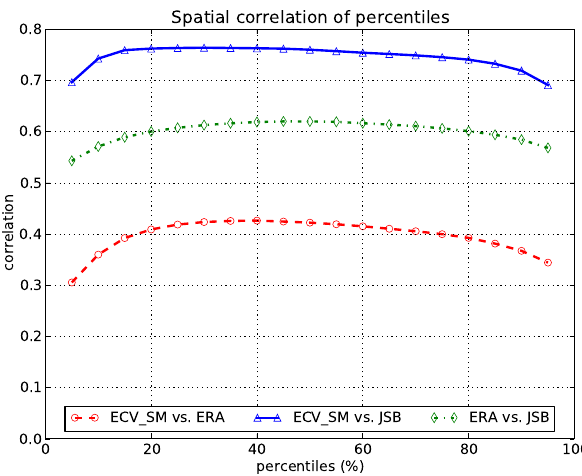
Fig. 5. Pearson product–moment correlation coefficients between the p -th percentiles of ERA-interim, JSBACH and ECVSM soil moisture fields.